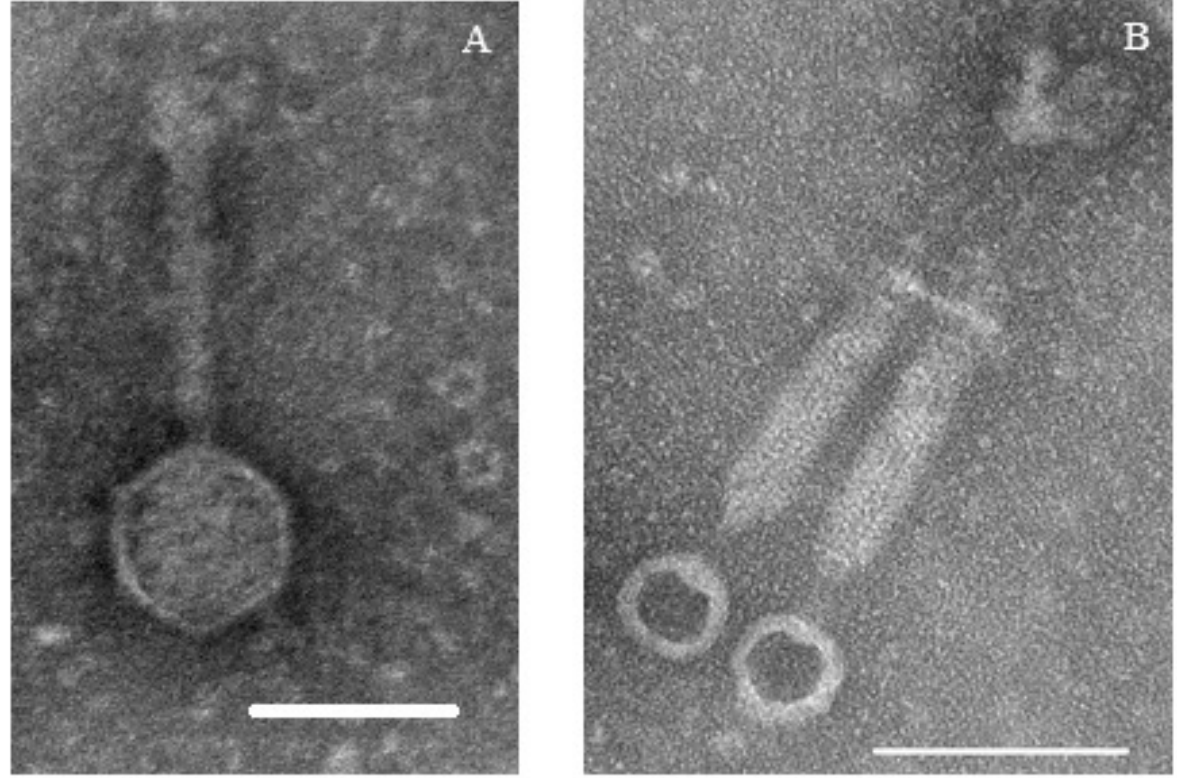
Figure 3 : Transmission electron micrographs of B . cereus bacteriophages: BaceFT01 (A) and BaceCM02 (B). The scale bars shown are 100